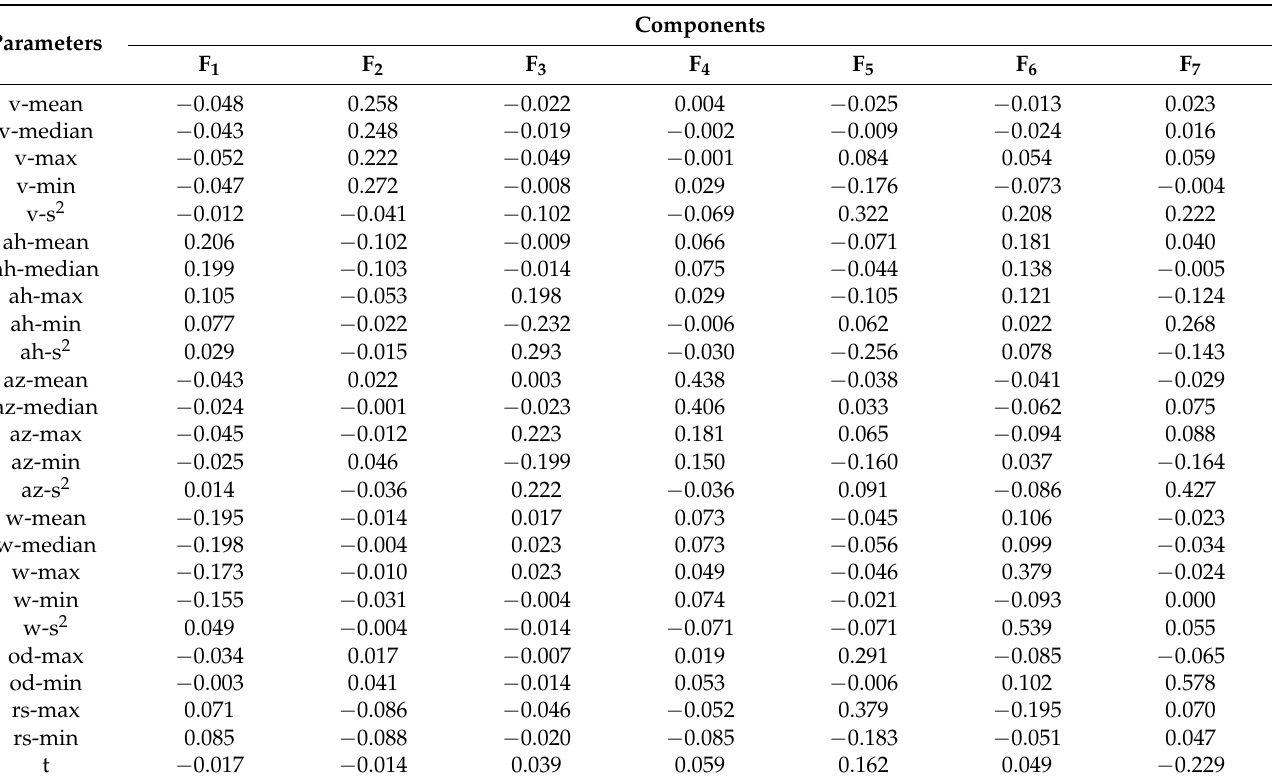
Table 3. List of score